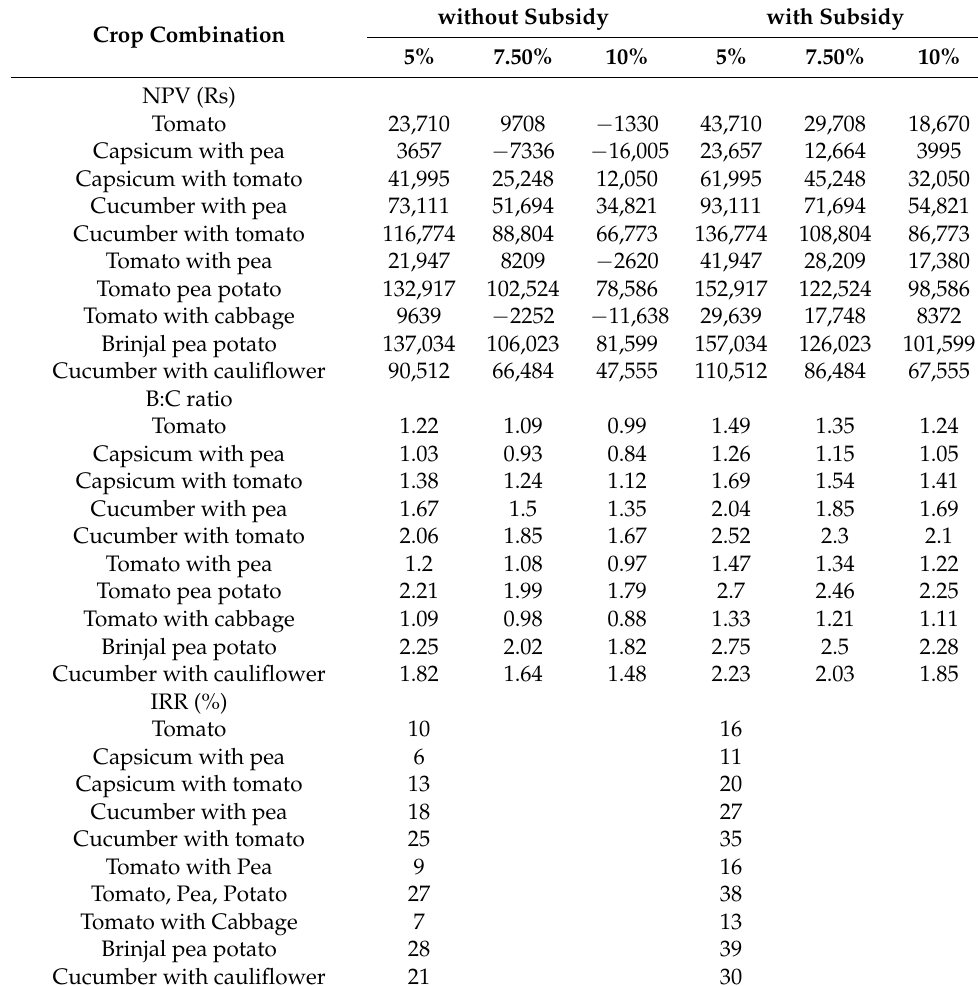
Table 16. Feasibility analysis of protected cultivation of vegetables under wood-based polyhouse in Almora district of Uttarakhand under climate change